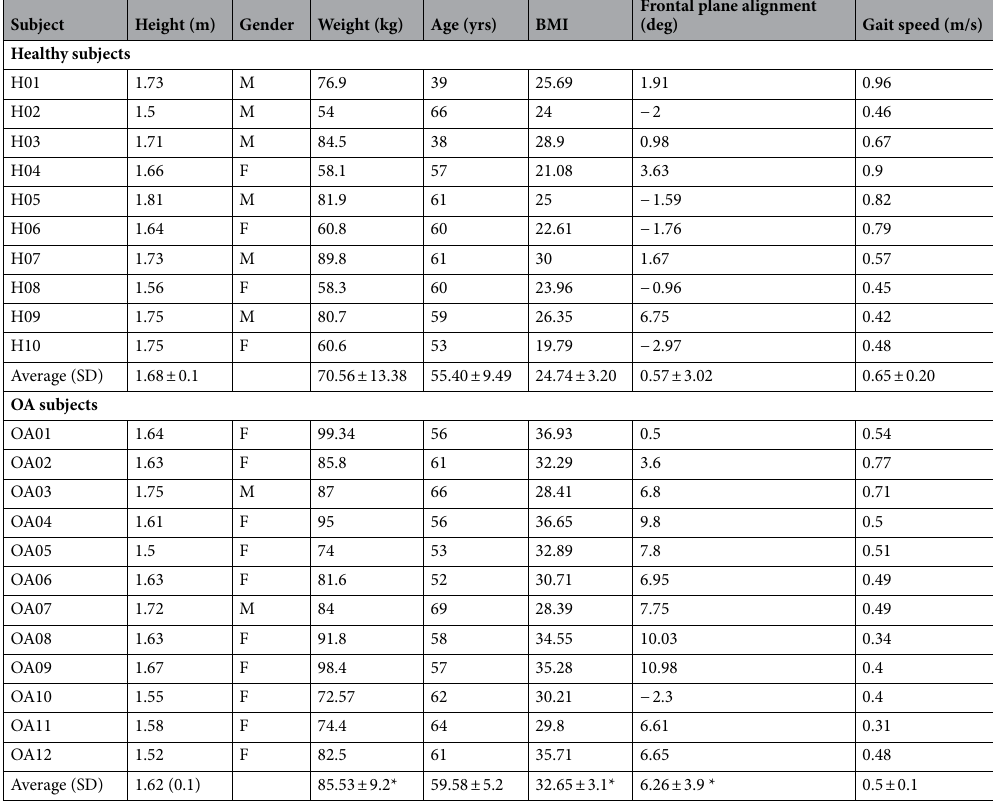
Table 1. The anthropometrics, frontal plane alignment and gait speed of 10 healthy (H) and 12 OA subjects. Average data ± 1 SD are provided; * denotes a statistically significant difference from the healthy group.